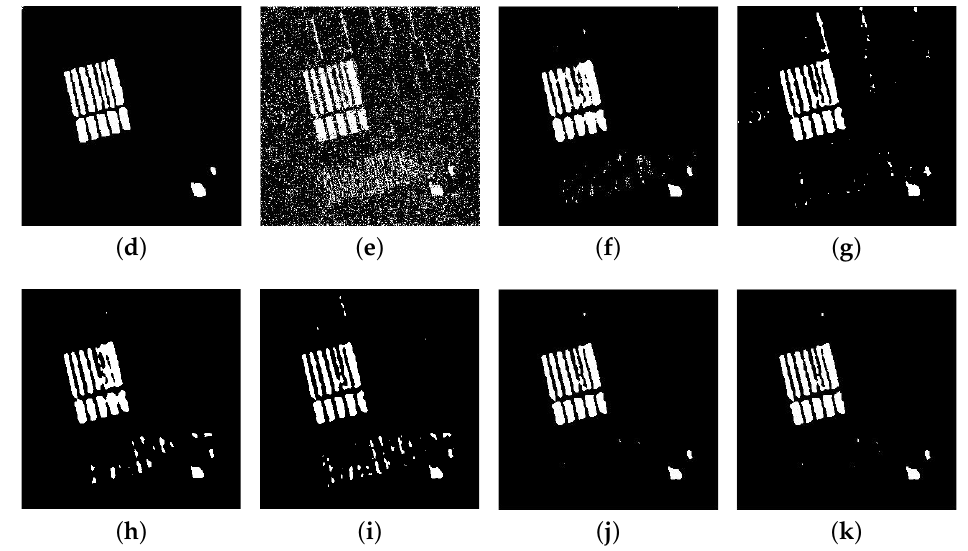
Figure 16. Change detection results of the Farmland C data set: ( a ) Reference. ( b ) FCM. ( c ) NLMFCM. ( d ) DBN. ( e ) SCCN. ( f ) Wavelet fusion. ( g ) gcForest. ( h ) The proposed method.